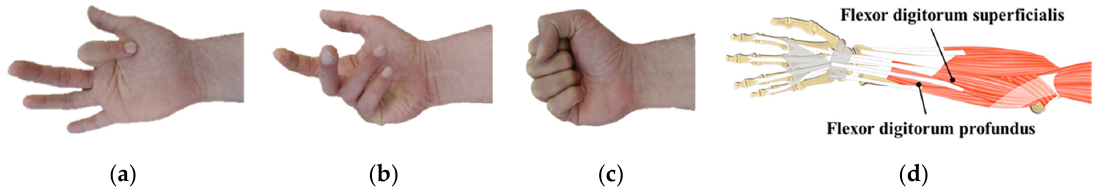
Figure 2. Illustrations of how to perform the three finger movements: ( a ) flexion of the index finger; ( b ) ordered flexion of all fingers one by one; ( c ) contemporary flexion of all fingers; ( d ) anatomy of the forearm with the muscles involved in the finger movements.